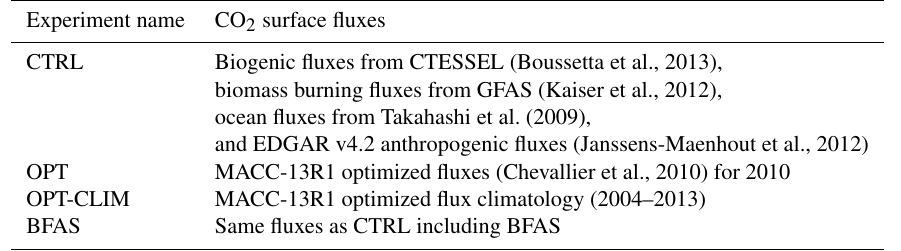
Table 2. List of simulations with the same transport and different CO 2 surface fluxes.